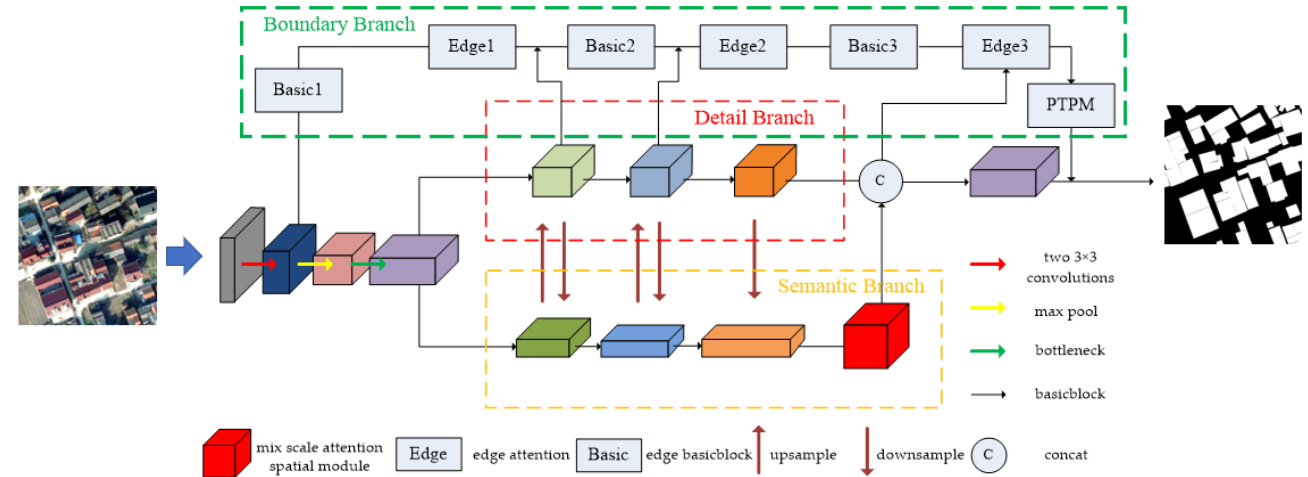
Figure 2. Overall network